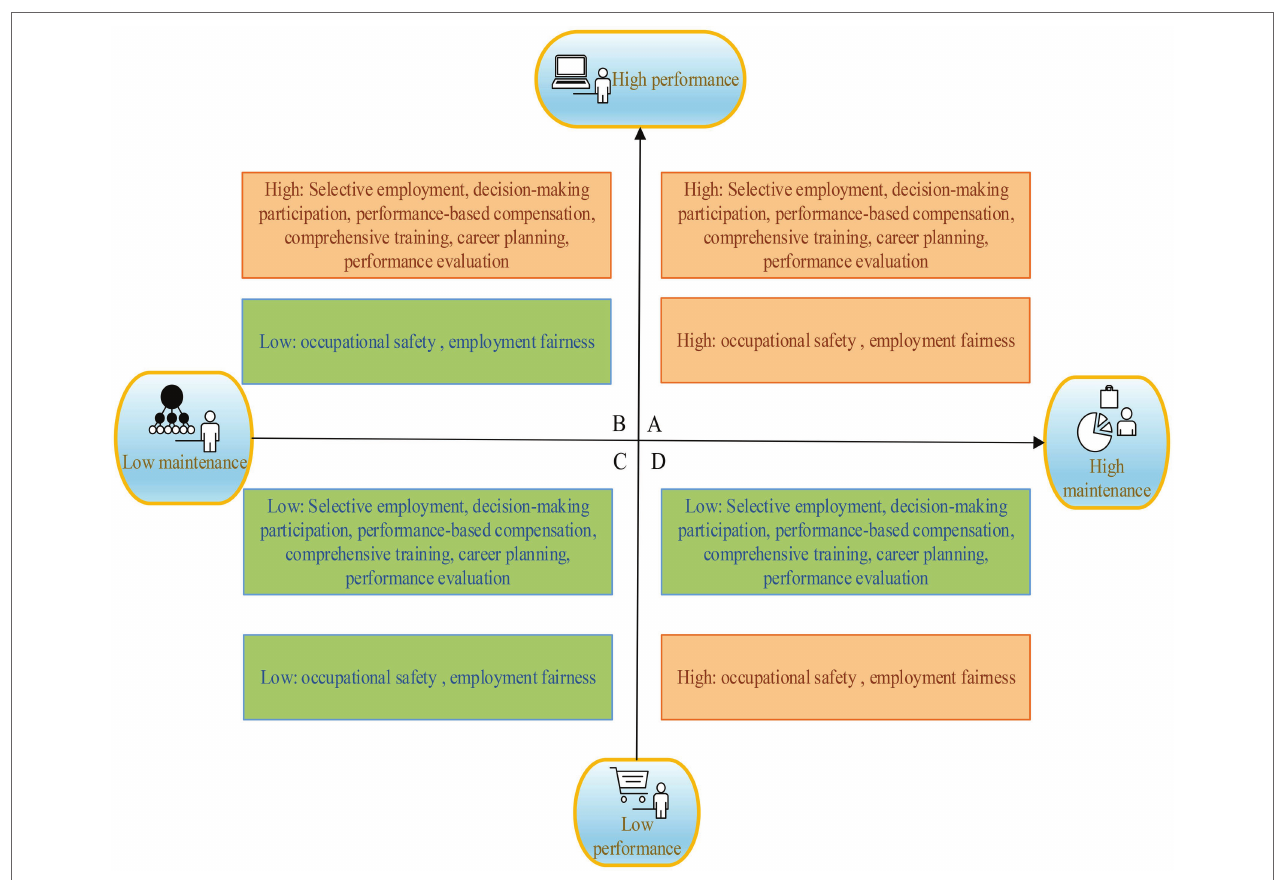
FIGURE 2 | Four classes of